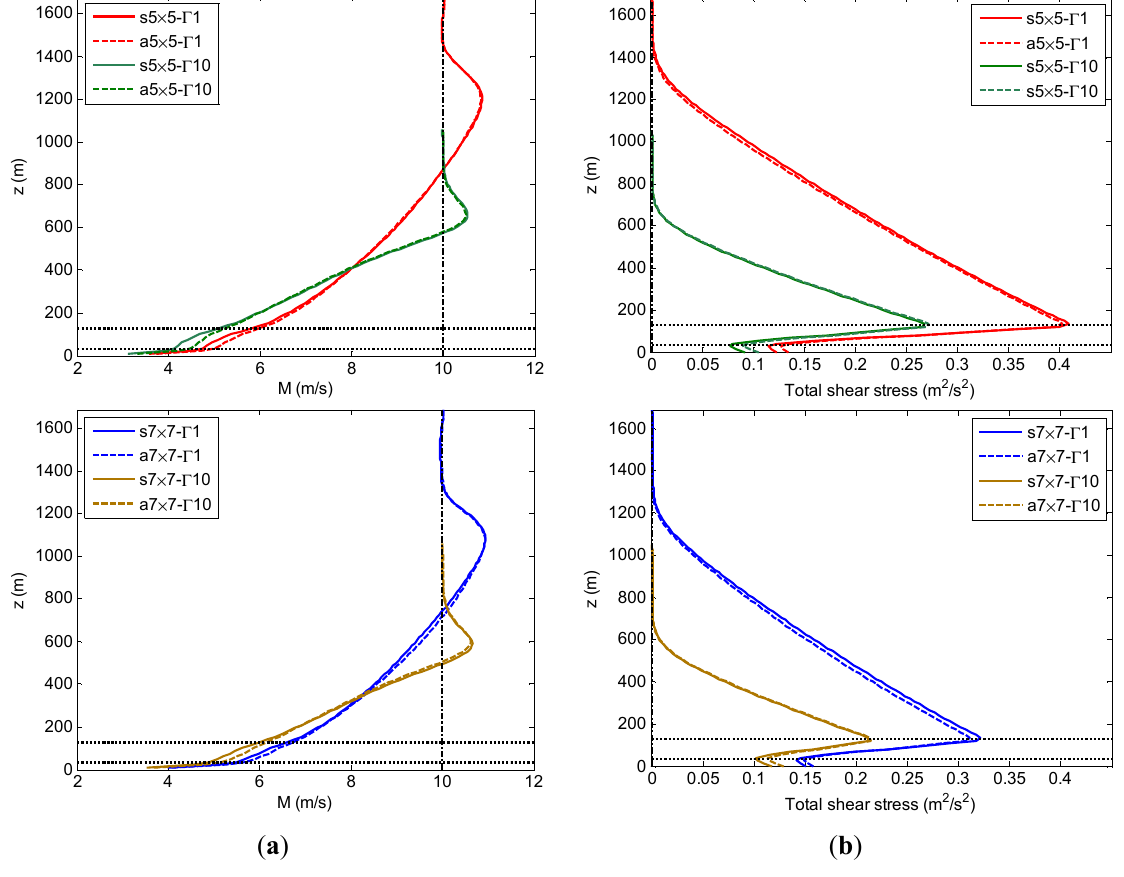
Figure 9. Vertical profiles of ( a ) horizontally-averaged velocity magnitude M; and ( b ) total shear stress for two different values of Γ and two different layouts.